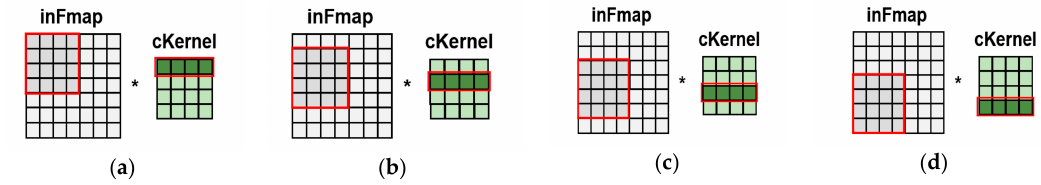
Figure 8. Generating partial sums row by row: ( a ) First; ( b ) Second; ( c ) Third; ( d )